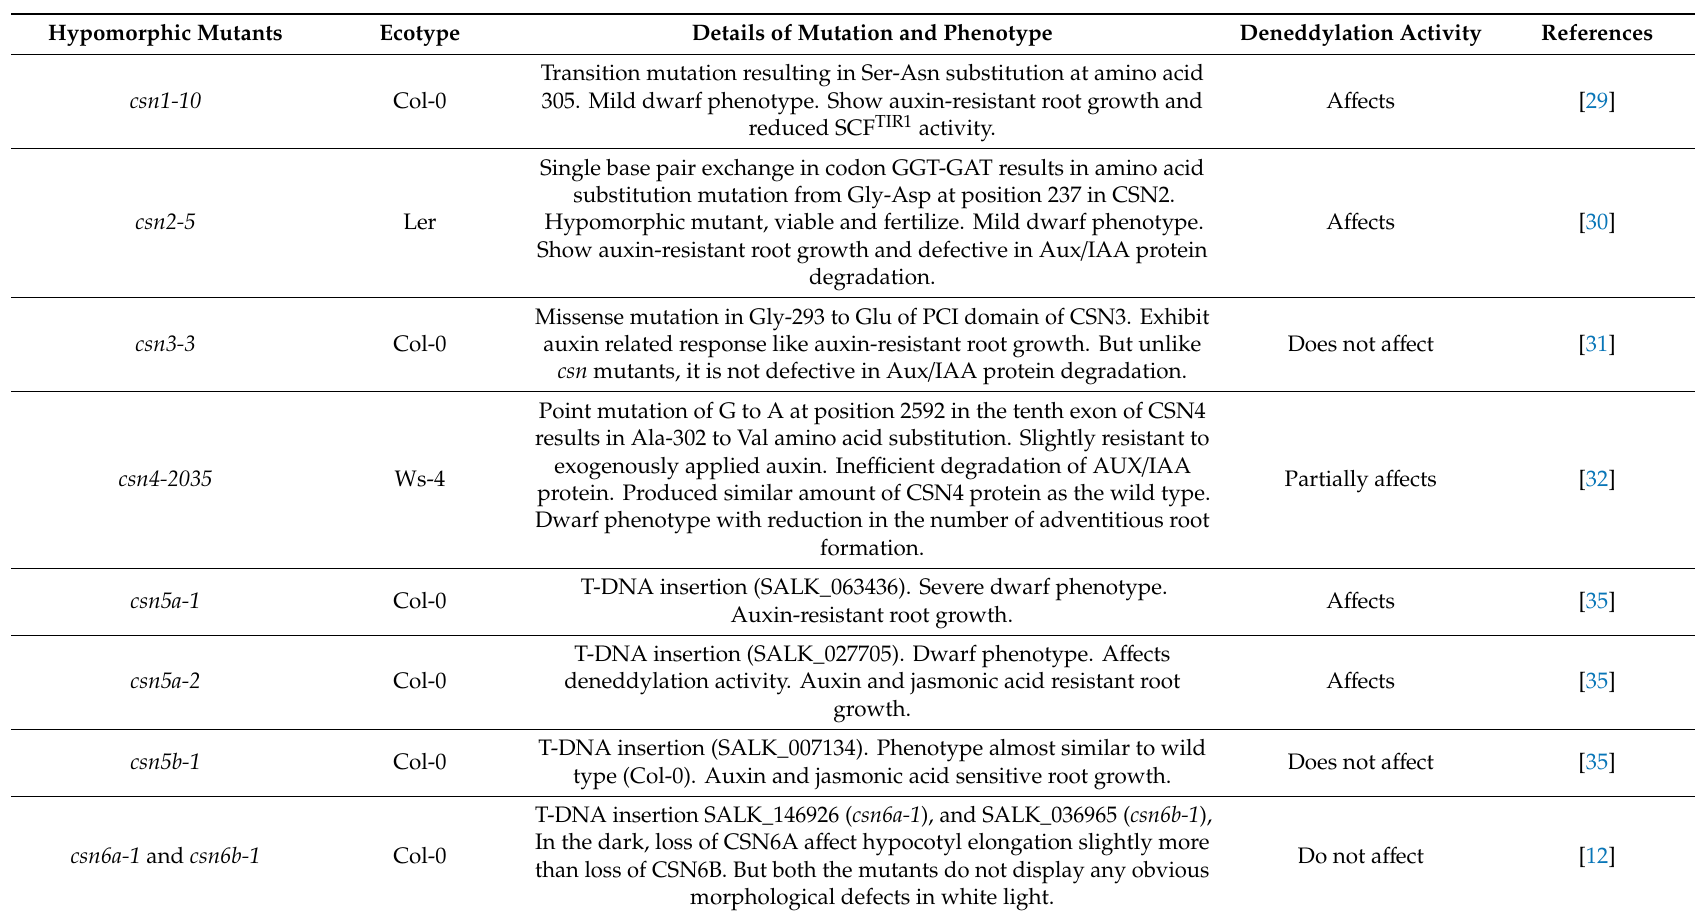
Table 1. Characterization of CSN hypomorphic